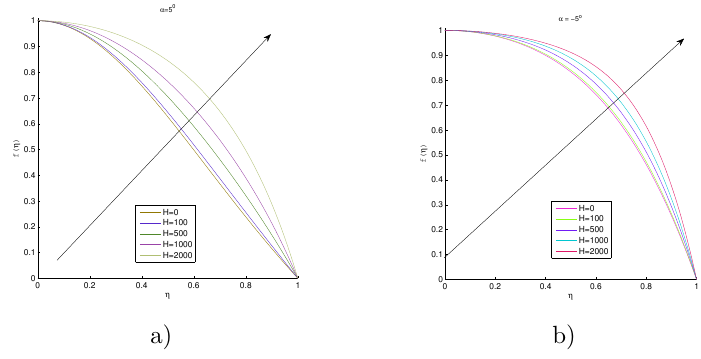
Figure 3. The 8 th -stage approximation obtained by the DRMA for Re = 50 and a) α = − 5 0 , b) α = 5 0